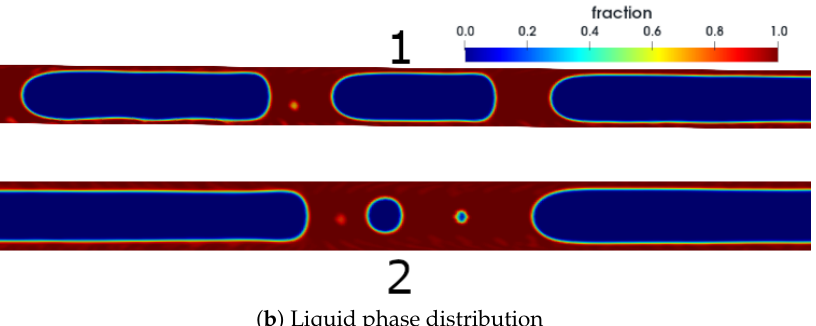
Figure 20. Numerical results of the Kafeel and Turan model [28] model in 1.0 s for 100 W input power.